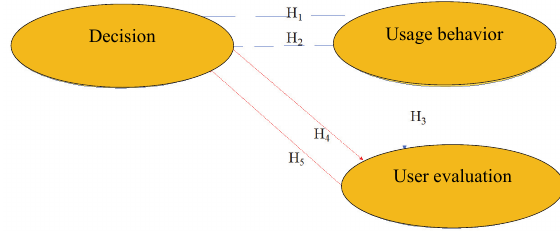
Fig. 1. The proposed